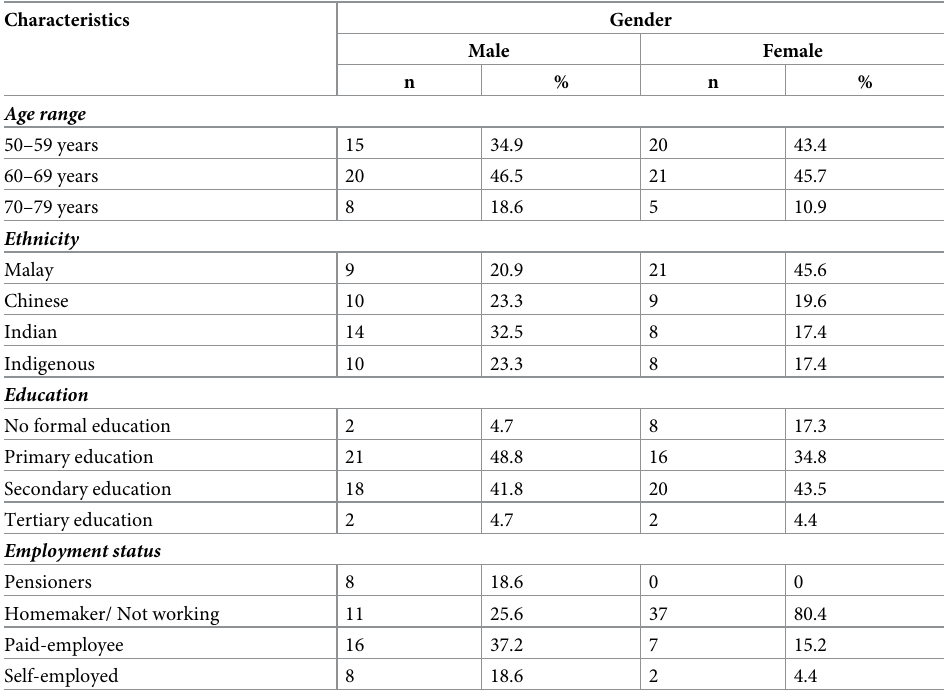
Table 1. Participant characteristics.